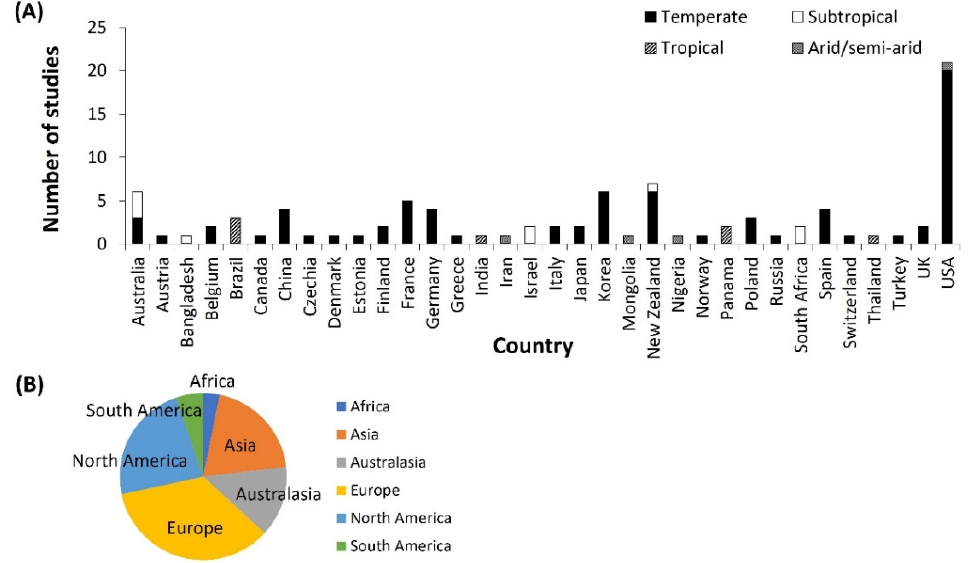
Figure 1. Summary of published studies investigating the morpho-physio-biochemical attributes of urban trees. ( A ) The number of studies and climate zone per country (excluding the following types of papers that covered global scale, commentary, opinion, forum, letters, communications, and articles focused only on environmentally controlled growth chamber/greenhouse conditions different from local climates), and ( B ) the total number of studies in our survey that are available from each continent.